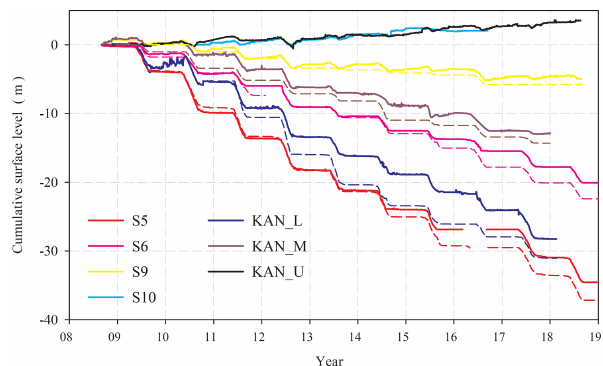
Figure 6. Measured height changes (solid lines) and modeled ice melt (dashed line) at the seven K-transect